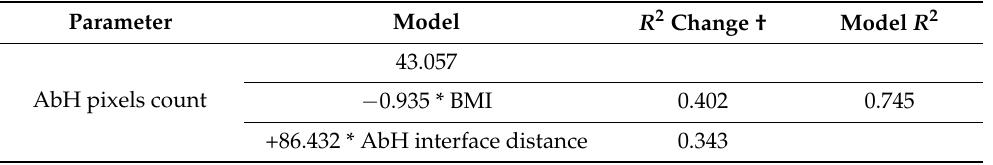
Table 2. Multivariate predictive analysis of ImageJ software analysis of count of the pixels of the